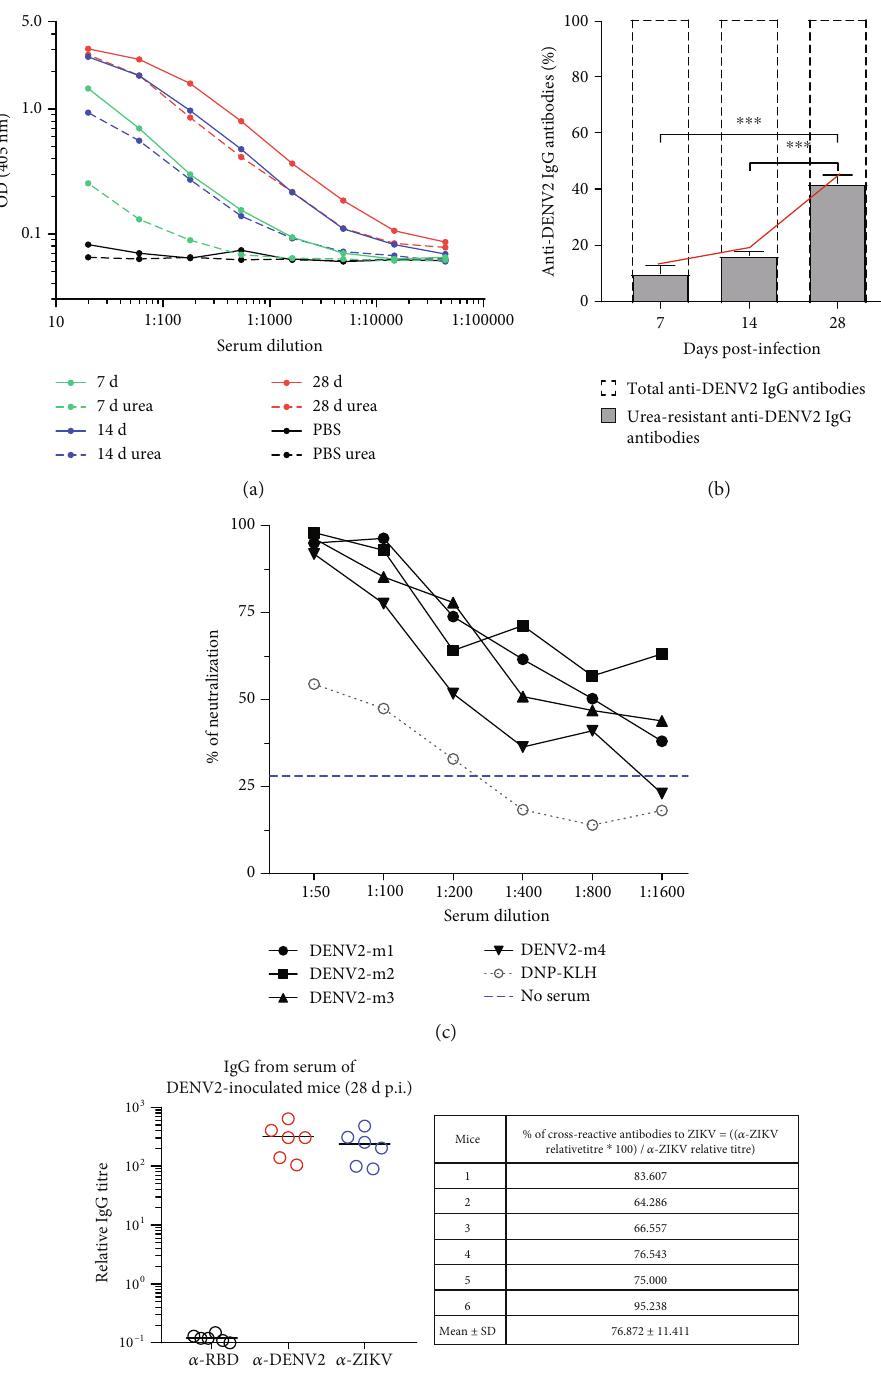
Figure 6: The a ffi nity of IgG antibodies to DENV increases with time after infection, has neutralizing activity, and can be broadly cross- reactive. Sera of mice inoculated with DENV were obtained at days 7, 14, and 28 p.i. and analyzed by ELISA in the presence or absence of urea 7M. (a) Graph showing the dilution curve of one representative sample per time point. Dashed lines represent the samples with urea 7M wash. (b) At each time point, the proportion of urea-resistant anti-DENV2 IgG antibodies (high a ffi nity, showed in grey bars) from the total anti-DENV2 IgG antibodies (indicated with dotted bars) is represented. Continuous red line represents the progressive increase in the a ffi nity of the IgG anti-DENV2 antibodies. (c) Percent of neutralization of DENV2 with serum from DENV-inoculated mice (mice 1 to 4, m1-m4) or serum from DNP-KLH-inoculated mice as negative control of neutralization. (d) Relative serum antibody titers for SARS-CoV-2 RBD-, DENV2-, and ZIKV-speci fi c IgG (left panel) and proportion of cross-reactive antibodies to ZIKV from sera of mice 28d p.i. with DENV2. Data shown represent the mean ± SEM of one experiment with 4 mice per time point (a – c) and two independent experiments with 3 mice per experiment (d) (b, one-way ANOVA test with Bonferroni posttest ∗∗∗ P < 0 : 001